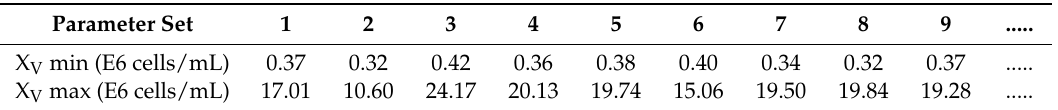
Table 3. Example of the parameter set (X V min) and target variable (X V max) resulting from 100 Monte Carlo simulations.